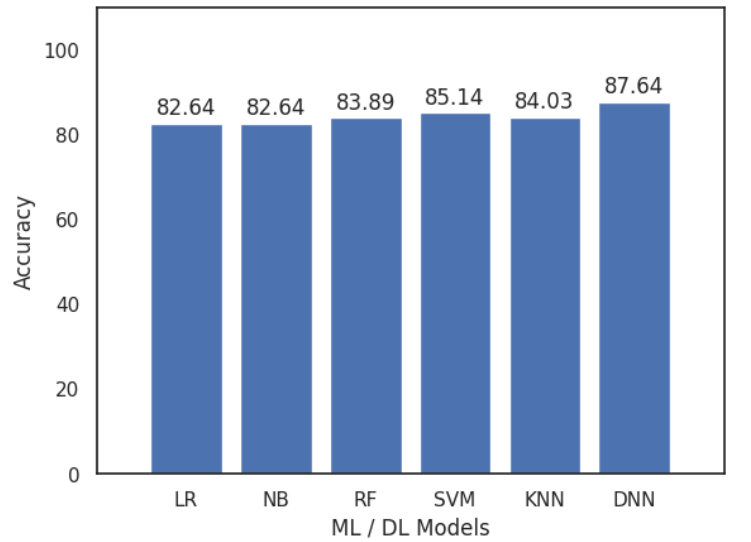
Figure 15. The pictorial representation of comparative accuracy estimation using different ML/DL models based on the stratified ten-fold cross-validation.